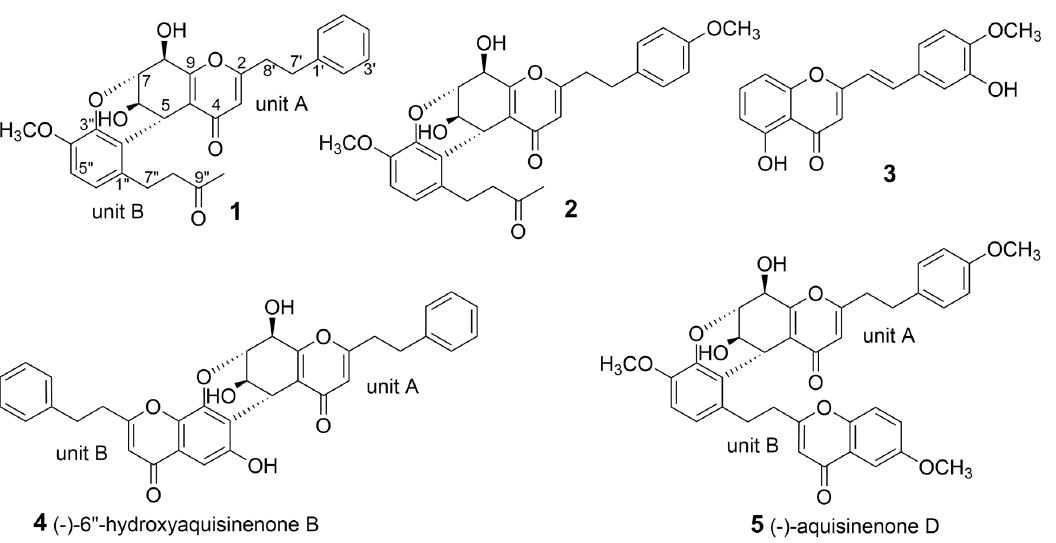
Figure 1. Chemical structures of 2-(2-phenylethyl)chromone derivatives 1 – 5 .